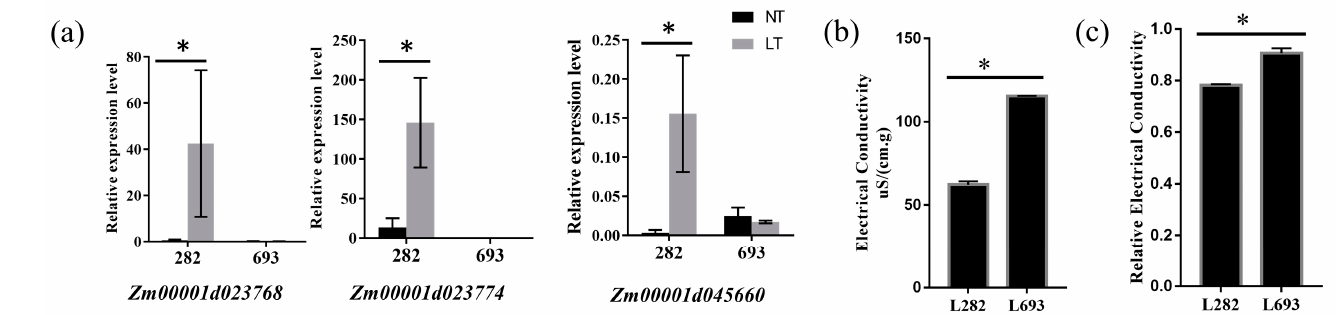
Figure 8. The membrane category was closely related to low-temperature tolerance in the inbred line L282. ( a ) qRT-PCR analysis of three sDEGs related to the plasma membrane system; ( b , c ) the comparison of electric conductivity ( b ) and relative electric conductivity ( c ) in L282 and L693 at low temperature. The asterisks indicate significant difference at p < 0.05 (n = 3).